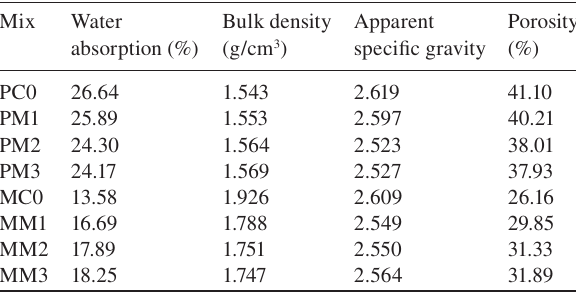
Table 5 Water absorption, bulk density, apparent specifi c gravity and porosity of cement